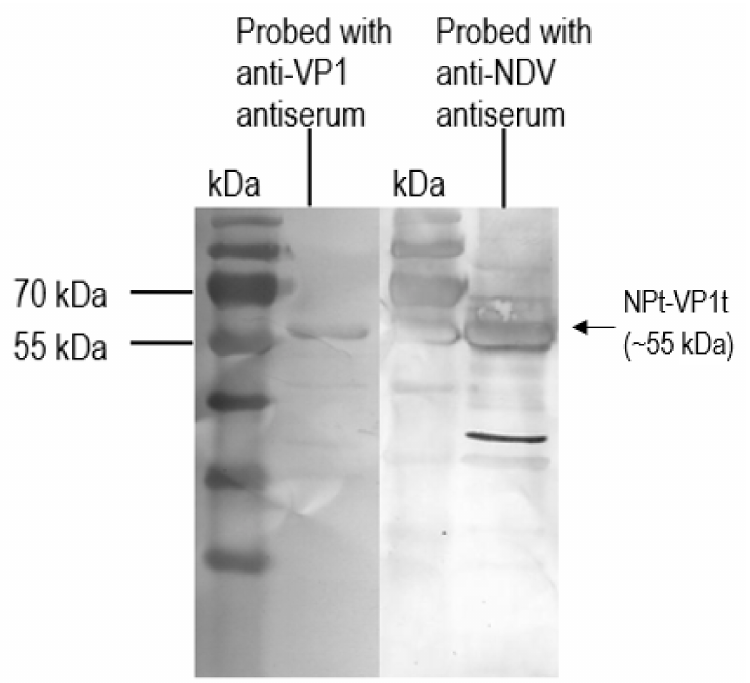
Figure 8. Detection of recombinant NPt-VP1 198–297 protein with anti-VP1 (lane 1) and anti-NDV (lane 2) rabbit antiserum.